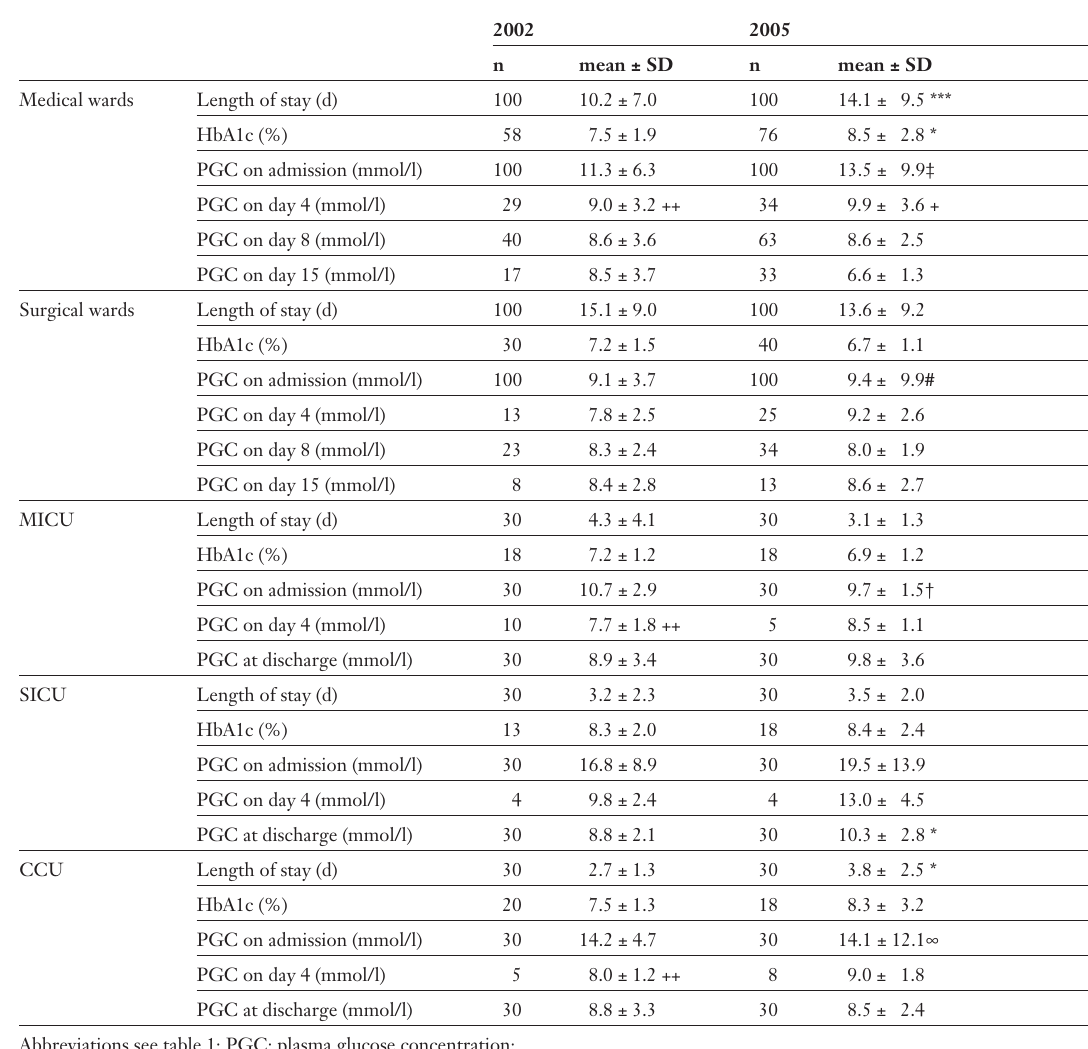
Plasma glucose concentrations during the stay and on discharge showed a decrease of PGC during the first four days of hospitalisation in 2002 and in 2005 (p = 0.006, resp. p = 0.024; fig. 1). In both years PGC in the MICU and SICU remained unchanged until discharge (fig. 2). PGC at discharge from the SICU was higher in 2005 than in 2002 (10.3 ± 2.8 mmol/l vs 8.8 ± 2.1 mmol/l, p = 0.021). There were few episodes of mild hypogly- caemia (none on the MICU, SICU and CCU in both years, three episodes on the medical and sur- gical wards in 2002, two on medical wards and one on the surgical wards in 2005) and no inci- dence of severe hypoglycaemia (PG <2.2 mmol/l). Antidiabetic therapy on admission Fewer patients were treated with diet only on medical wards in 2005 compared to 2002 (15 vs 31; p = 0.012), more patients were under insulin combination therapies (20 vs 5 under single in- sulins; p = 0.003). On surgical wards in 2005 more patients were under oral antidiabetic medication alone than in 2002 (67 vs 50; p = 0.022).